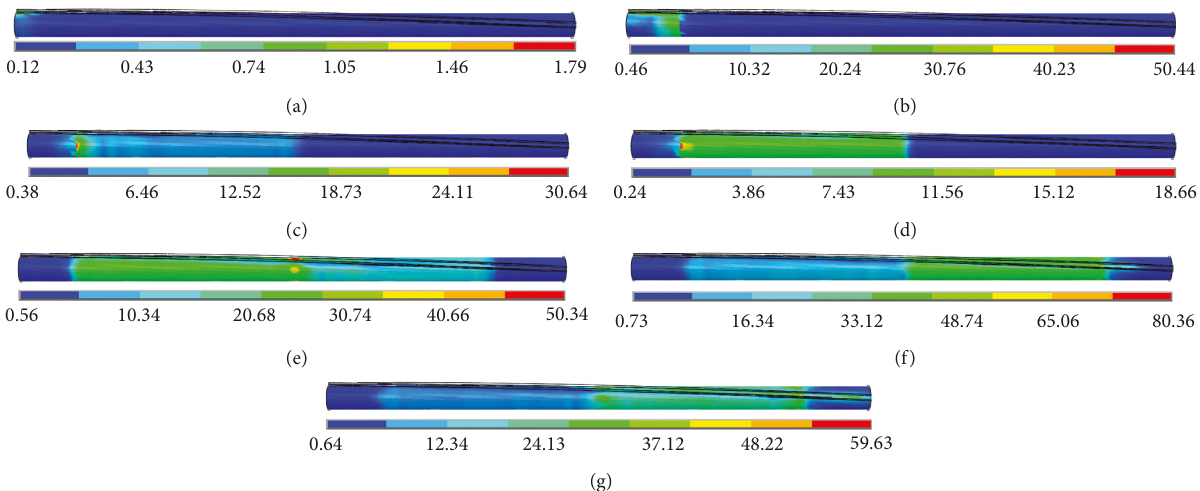
Figure 10: von Mises stress distribution of the inner surface under unsteady temperature field in different time periods. (a) 30ms. (b) 40ms. (c) 50ms. (d) 60ms. (e) 70ms. (f) 80ms. (g) 90ms.